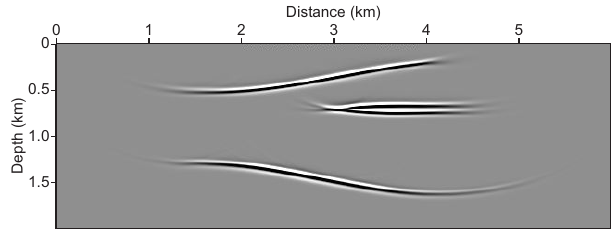
Fig. 3. Migrated image of the synthetic example. Figure 3. Migrated image of the synthetic example.